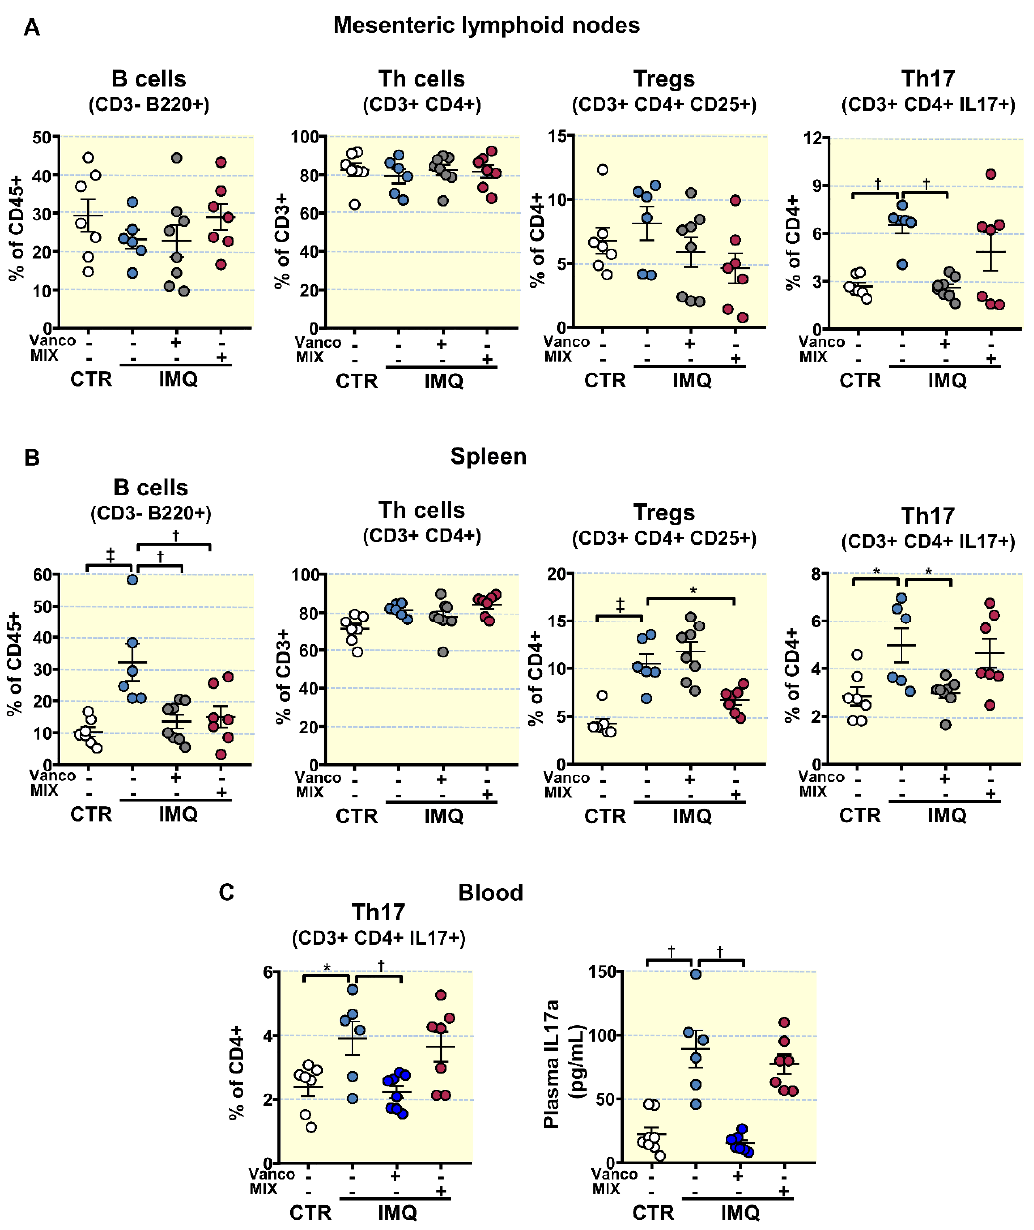
Figure 3. Effects of treatment with antibiotics on lymphocyte activation and proliferation in imiquimod (IMQ) animals. ( A ) Total B lymphocytes, T helper (Th), Regulatory T (Treg), and Th17 cells as detected with flow cytometry in mesenteric lymph nodes, ( B ) in spleen, and ( C ) blood Th17 cells and plasma IL17a levels from control (CTR), IMQ and IMQ concom- itantly treated with Vancomycin (VANCO) or our cocktail of antibiotics (MIX). Data is represented as means ± SEM. The variables were tested with one-way ANOVA and Tukey post hoc test. Plasma IL17a levels were compared using Kruskal–Wallis with Dunn’s multiple comparisons test. * p < 0.05, † p < 0.01, ‡ p < 0.001 compared to the CTR group; * p < 0.05, † p < 0.01 compared to the untreated IMQ group.